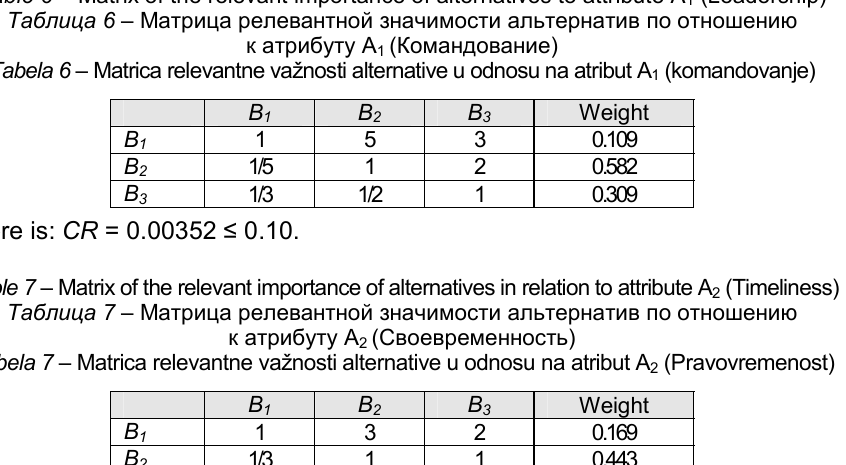
Table 6 – Matrix of the relevant importance of alternatives to attribute A 1 (Leadership) Таблица 6 – Матрица релевантной значимости альтернатив по